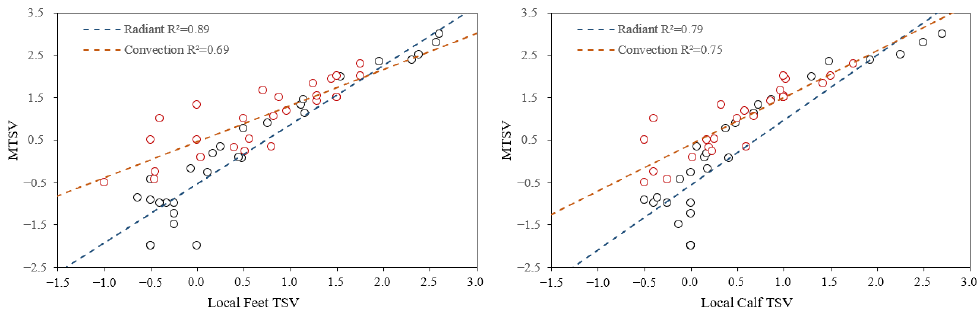
Figure 8. Overall and local thermal sensory regression analysis.